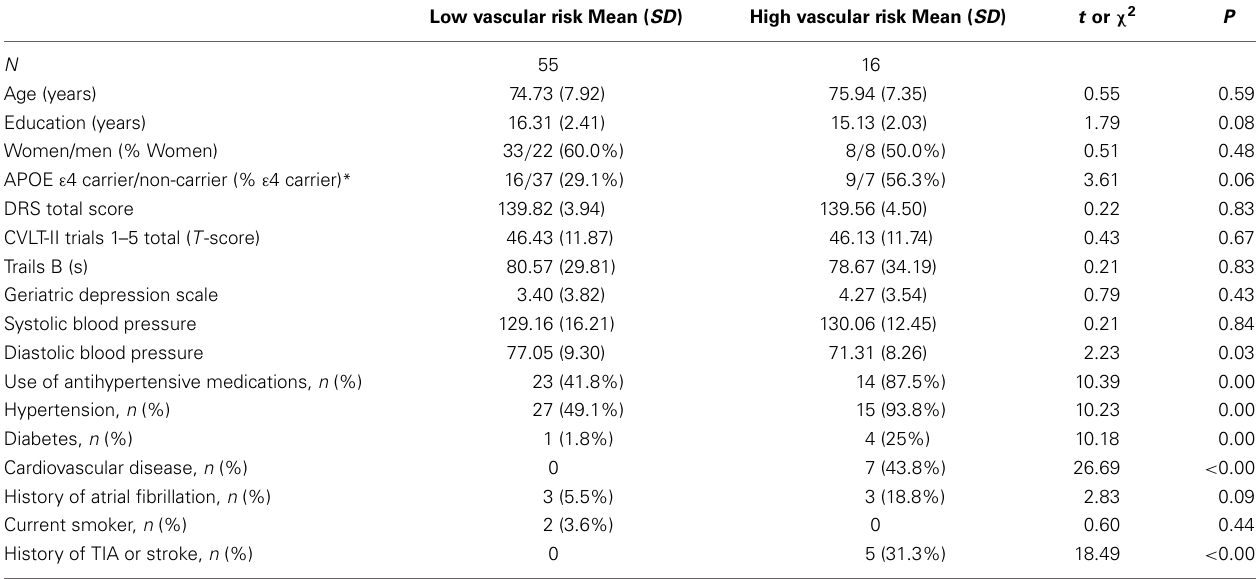
Table 1 | Demographic and clinical characteristics of